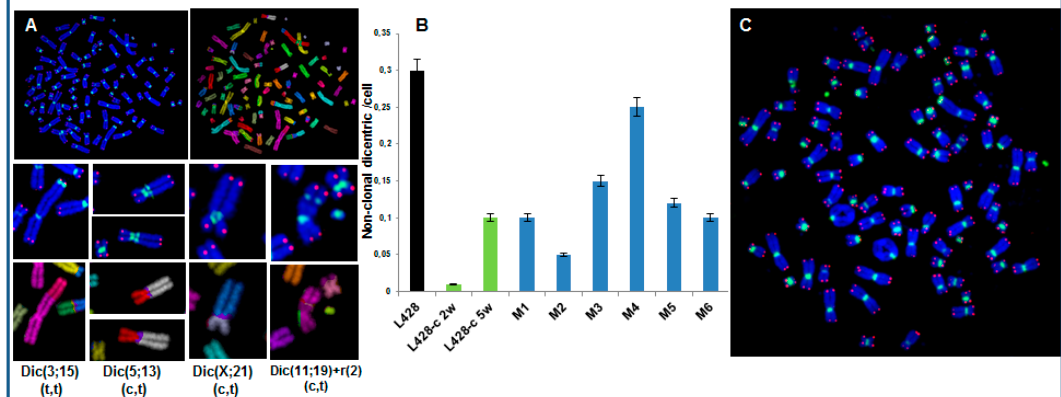
Figure 8. Dicentric chromosomes and centric rings in HL cells. ( A ) Clonal dicentric chromosomes in L428 cells, L428-c cells, and HL cells recovered from mouse liver. The dicentric chromosomes are characterized by telomere (t,t) and/or centromere (c,t) breakpoints detected by telomere and centromere staining followed by M-FISH. ( B ) Frequency of non-clonal dicentric chromosomes in parental L428 cells, cells of the L428-c subline after two and five weeks of expansion, and HL cells recovered from mouse livers (M1–M6). ( C ) Representative image of a metaphase with a non-clonal ring of chromosome 4 related to telomere fusion in an HL cell from mouse liver (63× magnification).